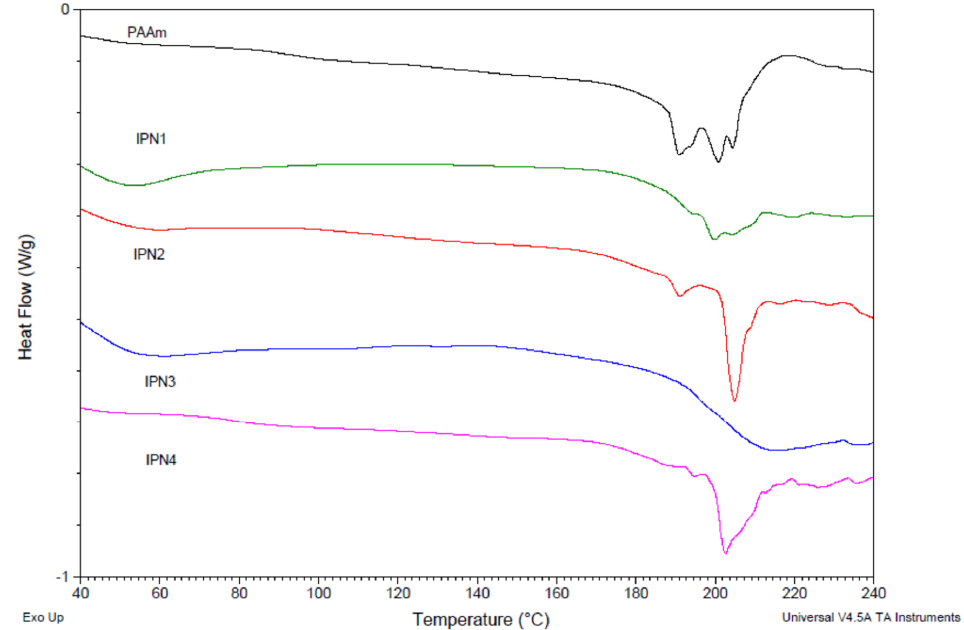
Figure 5. DSC thermograms of PDMAEMA/PAAm IPNs as well as of the single PAAm network.